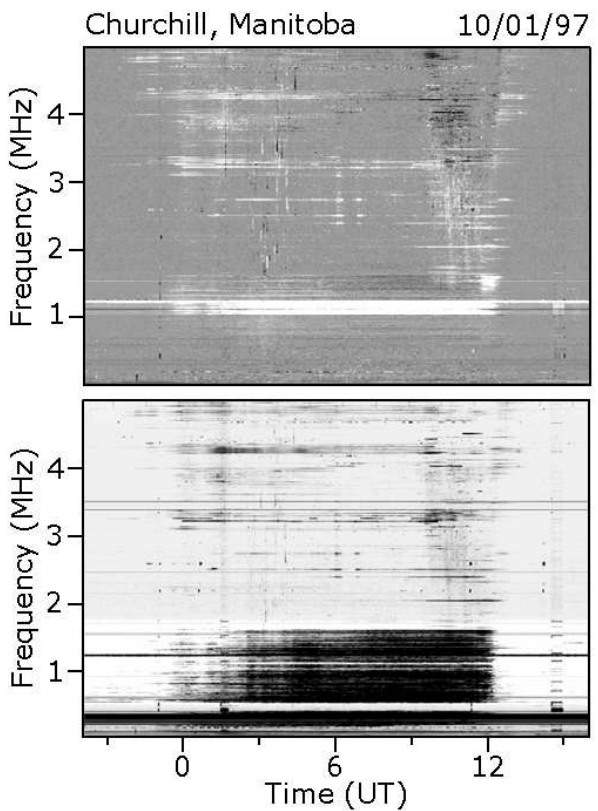
Fig. 5. (a) Polarization of 50–5000kHz signals recorded at Churchill, Manitoba, on 1–2 October 1997. White pixels indi- cate left-hand polarization, black pixels indicate right-hand polar- ization, and gray pixels indicate indeterminant polarization. (b) Power spectral density of the same 50–5000kHz signals. Received signals above 1MHz are predominantly left-hand polarized except in the interval 09:00-12:00UT, 1–4h before sunrise, when right- hand waves dominate at frequencies above about